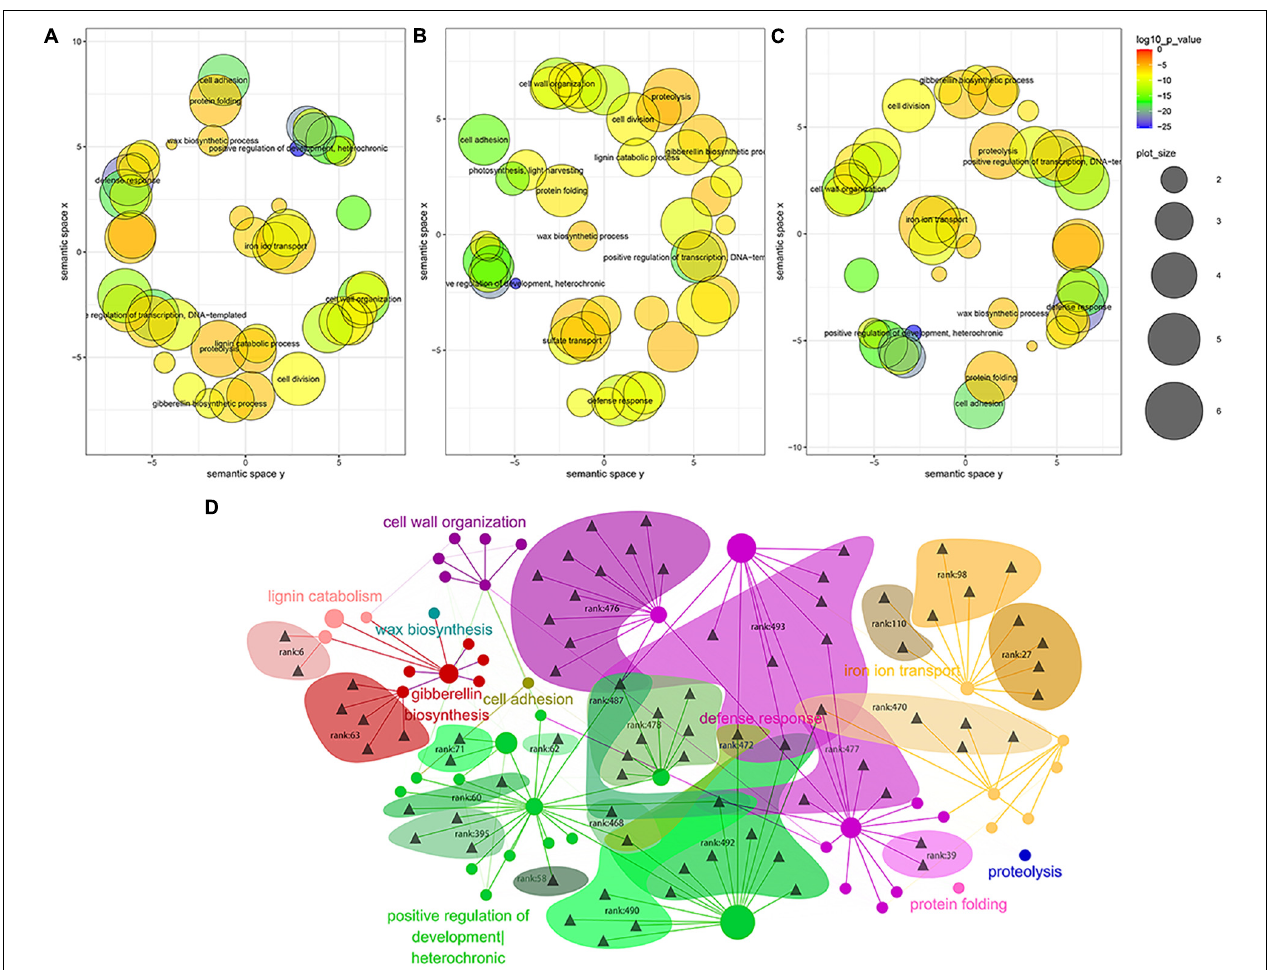
FIGURE 3 | Gene ontology (GO) term analysis of MTRM genes under various abiotic stresses (A–C) . (A) GO semantic correlation analysis of abiotic stress, (B) drought stress, and (C) salt stress, and (D) the GO BP regulatory network of cooperative miRNAs under abiotic stresses. Triangles represent different miRNAs and circles represent different GOs. The size of the circle is determined by the number of genes contained in the GO in this article. The color of the circle depends on the representative GO. The areas with different colors show the modules obtained by our method.